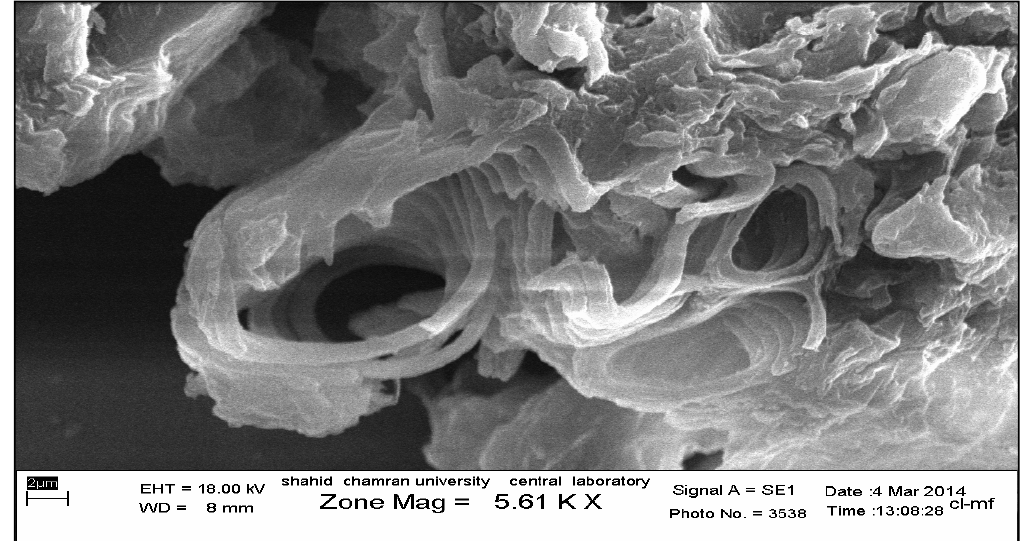
Figure 2. Scanning electron microscope (SEM) image of acid-activated spent tea